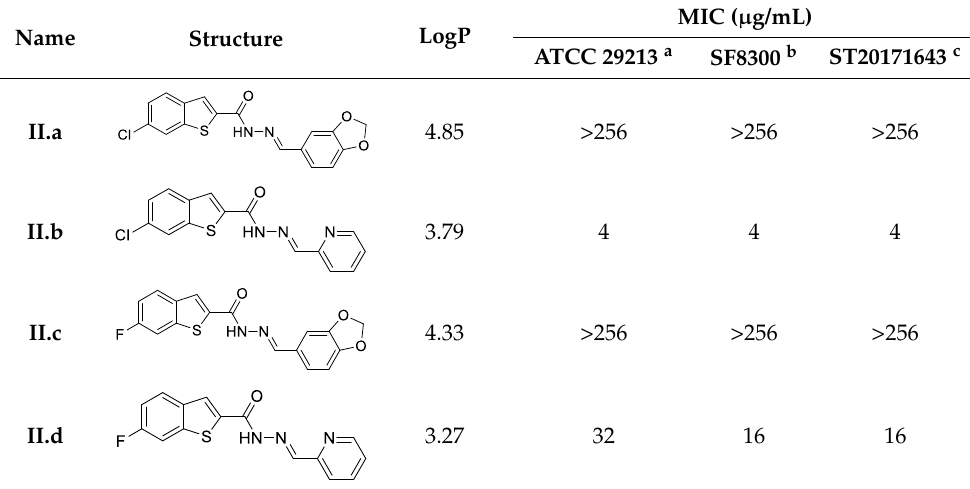
Table 2. Minimum inhibitory concentrations of set II molecules against S. aureus strains.